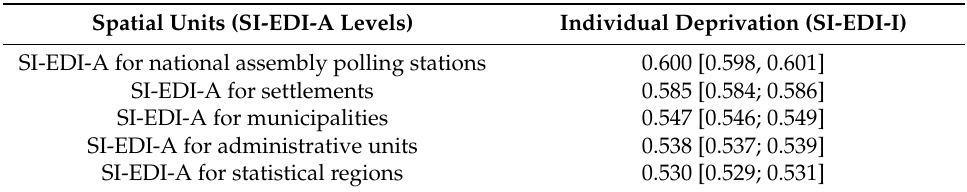
Table 2. Areas under curves (AUC) with 95% confidence interval of the receiver operating characteristics of ecological deprivation indices compared to individual deprivation index (aggregated and individual data from population census in 2011).